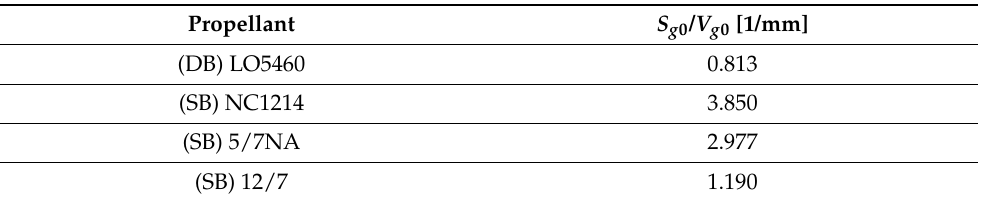
Table 1. Values of the ratio of the initial grain surface to the initial volume for propellants referred to in the paper.